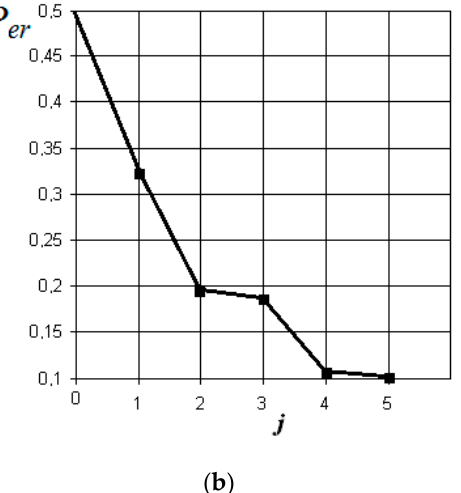
Figure 6. The results of discriminant data analysis when comparing the norm with acute serous odontogenic sinusitis: ( a ) the dependence of the increase in the normalized Euclidean distance as signs are added to the discrimination model δ = f ( j ) ; ( b ) the dependence of the decrease in the probability of a decision error as signs are added to the discrimination P f(j) : j = 5 is the dimension of the space of informative parameters.